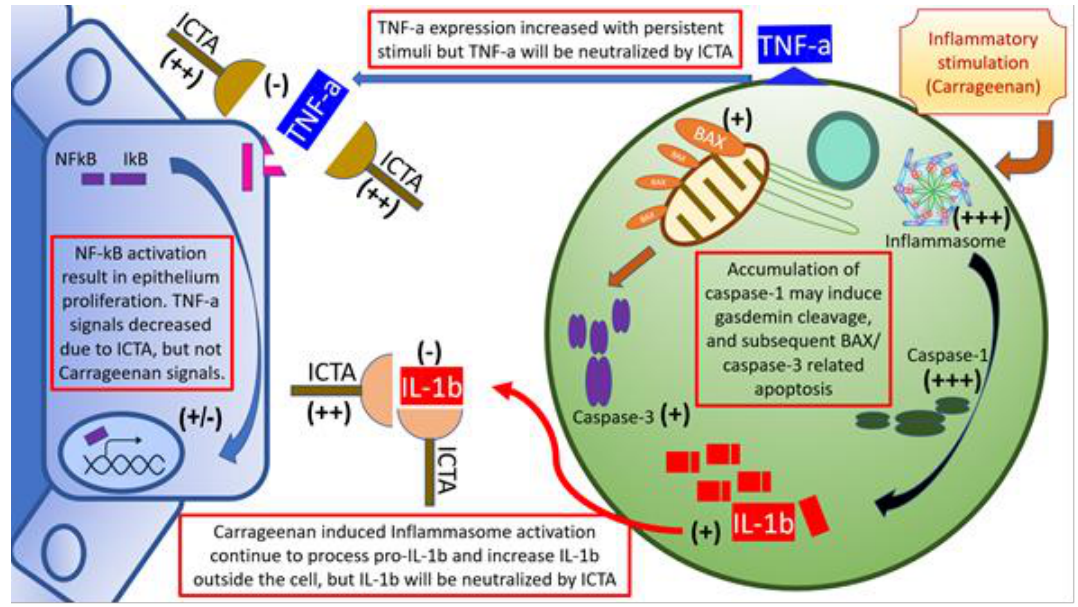
Figure 6. Schematic illustration of inflammatory cytokine-targeting aptamers (ICTA) and interstitial mononuclearcellinteractionintheprostateofcarrageenan-inducedlocalinflammation. Localcarrageenan exposure led to prostate inflammation, including increases of mononuclear cell infiltration activation, and endothelium-related pro-inflammatory cytokines interleukin-1 beta (IL-1b), and tumor necrosis factor-alpha (TNF-a), which induced a positive feedback loop. The above effects may have caused prostate acinar endothelium to undergo hyperplastic change, and interstitial space to become edematous and excessively prominent in the chronic pelvic pain syndrome (CPPS) group, which enhanced pain sensitivity (allodynia and hyperalgesia) in CPPS rats. These compromises in both prostate structure and animal behaviors are affected by ICTA (aptamer neutralizing IL-1b and TNF-a). When cells are overloaded with the active inflammasome pathway, it may induce gasdermin D (GSDMD)-mediated cell death due to caspase-1 overexpression [22]. Cleaved gasdermin can permeabilize the mitochondrial membrane to trigger the mitochondrial apoptotic pathway, which can be demonstrated by the increased caspase-3 cleavage and B-cell lymphoma 2-associated X protein (BAX) expression in the ICTA-treated CPPS group. This suggested that proinflammatory cytokine neutralization may work through inducing apoptosis in inflammatory